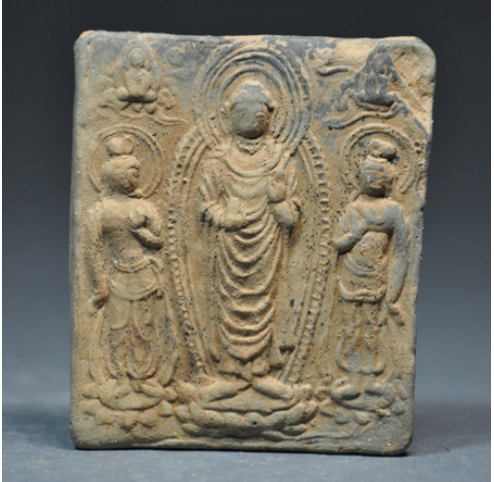
Figure 17. Clay Buddha, Unified Silla, 8.3 × 7.3 cm, An’gang Kapsan-ri temple site, Ky˘ongju, Korea [©Photograph by Lim, 2016].